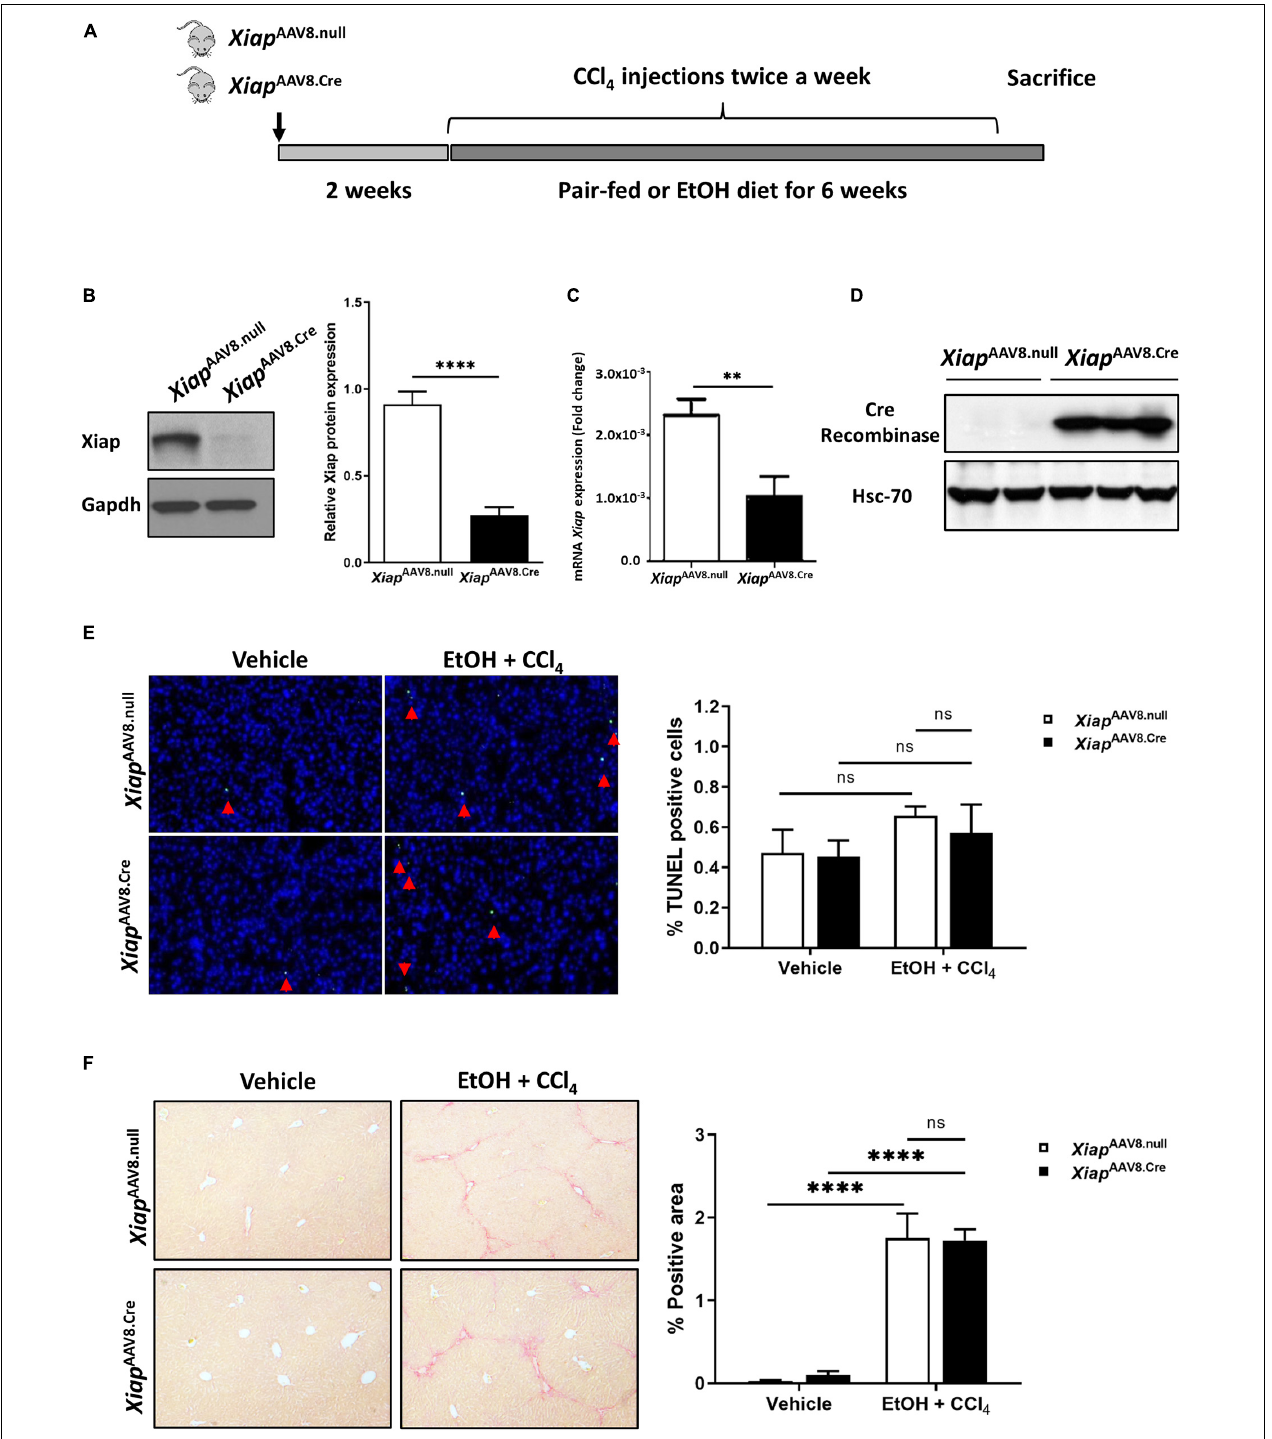
FIGURE 4 | Hepatocyte-specific AAV8 deletion of Xiap does not exacerbate injury in EtOH plus CCl4 mouse model. (A) Schematic representation of the mouse model. (B) Protein levels of Xiap determined by Western blot in Xiap AAV 8 . null and Xiap AAV 8 . Cre mice. Gapdh protein levels were used as a loading control for total protein. (C) Evaluation of Xiap deletion by qRT-PCR in Xiap AAV 8 . null and Xiap AAV 8 . Cre mice. Xiap mRNA levels were expressed as fold change. Gapdh was used as a housekeeping gene. (D) Protein levels of Cre-Recombinase determined by Western blot in Xiap AAV 8 . null and Xiap AAV 8 . Cre mice. Hsc-70 protein expression was used as a loading control for total protein. (E,F) Histological evaluation of the role of Xiap in liver tissues collected from Xiap AAV 8 . null and Xiap AAV 8 . Cre mice that underwent ethanol or paired-feeding and were administered olive oil or CCl 4 . TUNEL (E) and Sirius red staining (F) were performed. Representative images and quantifications from mice liver tissues are shown. Image magnification 10X ( ∗∗ p < 0.01; ∗∗∗∗ p < 0.001; ns, no significance, and n = 3–7).